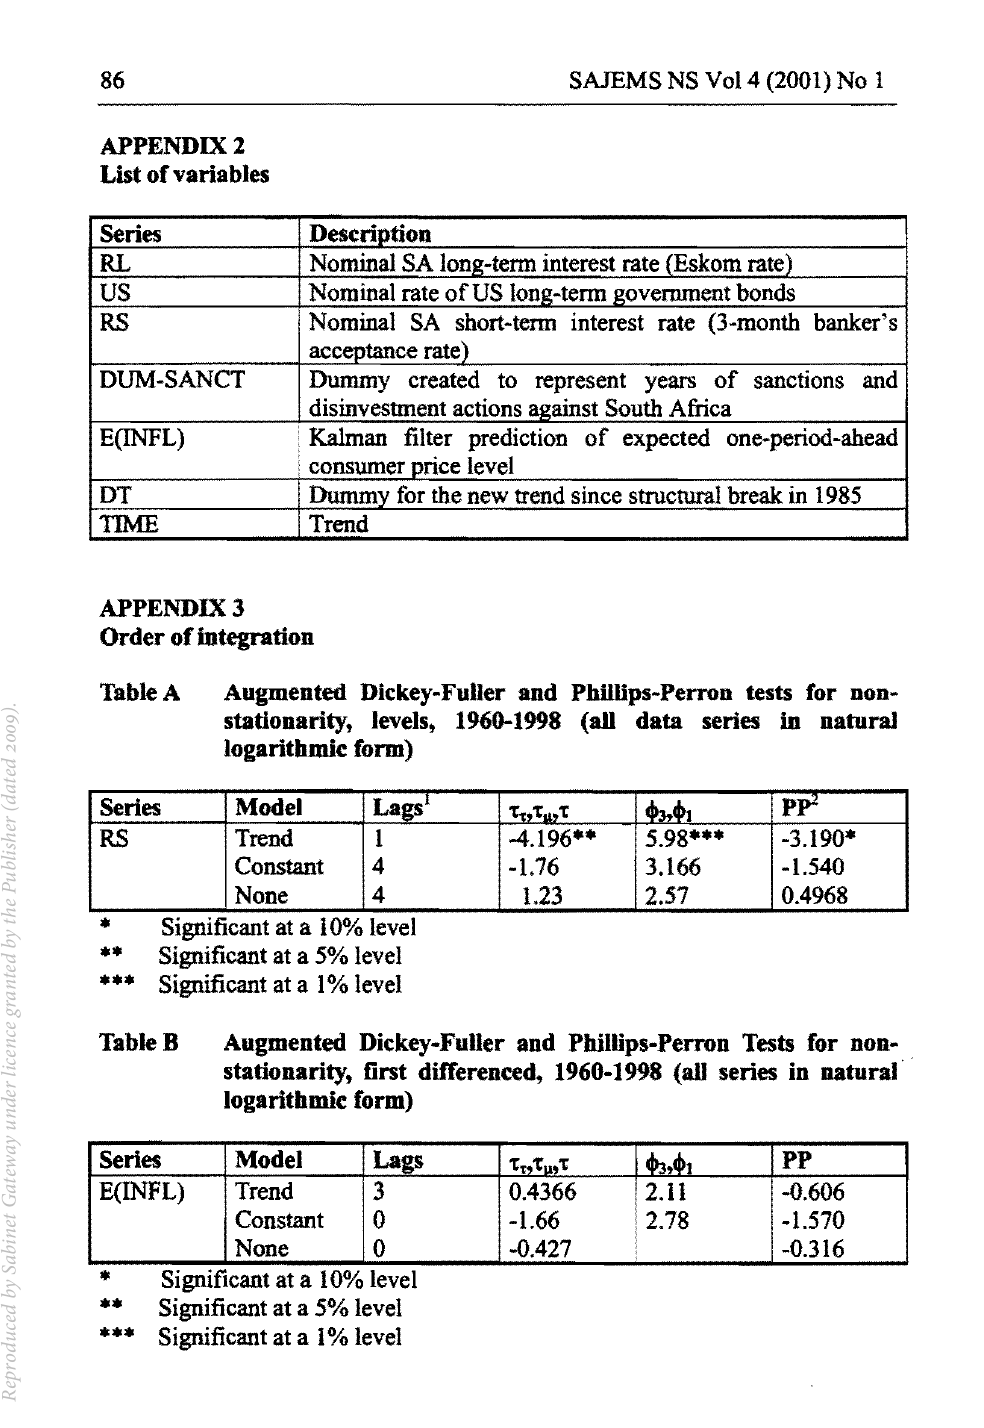
Augmented Dickey-Fuller and Phillips-Perron tests for non stationarity, levels, 1960-1998 (all data series in natural logaritbmic form)